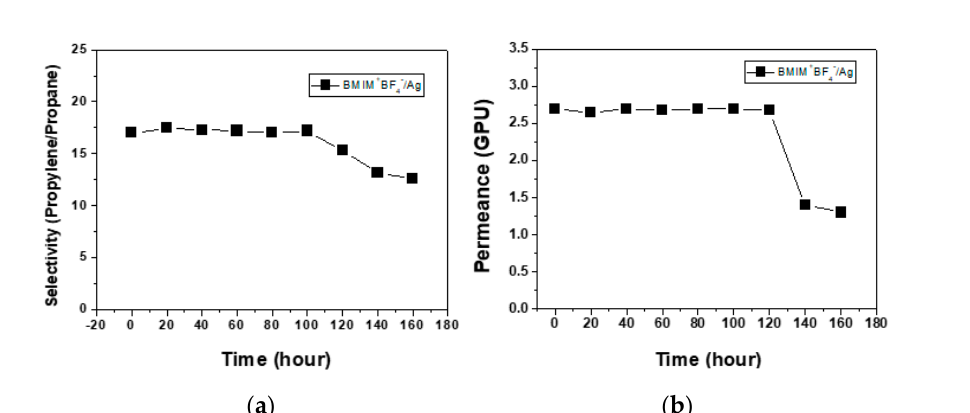
Figure 2. Separation performance: ( a ) mixed gas selectivity and ( b ) total permeance of 1/0.7 BMIM + BF 4 − /Ag membranes as a function of time (40 psig and 20 °C).